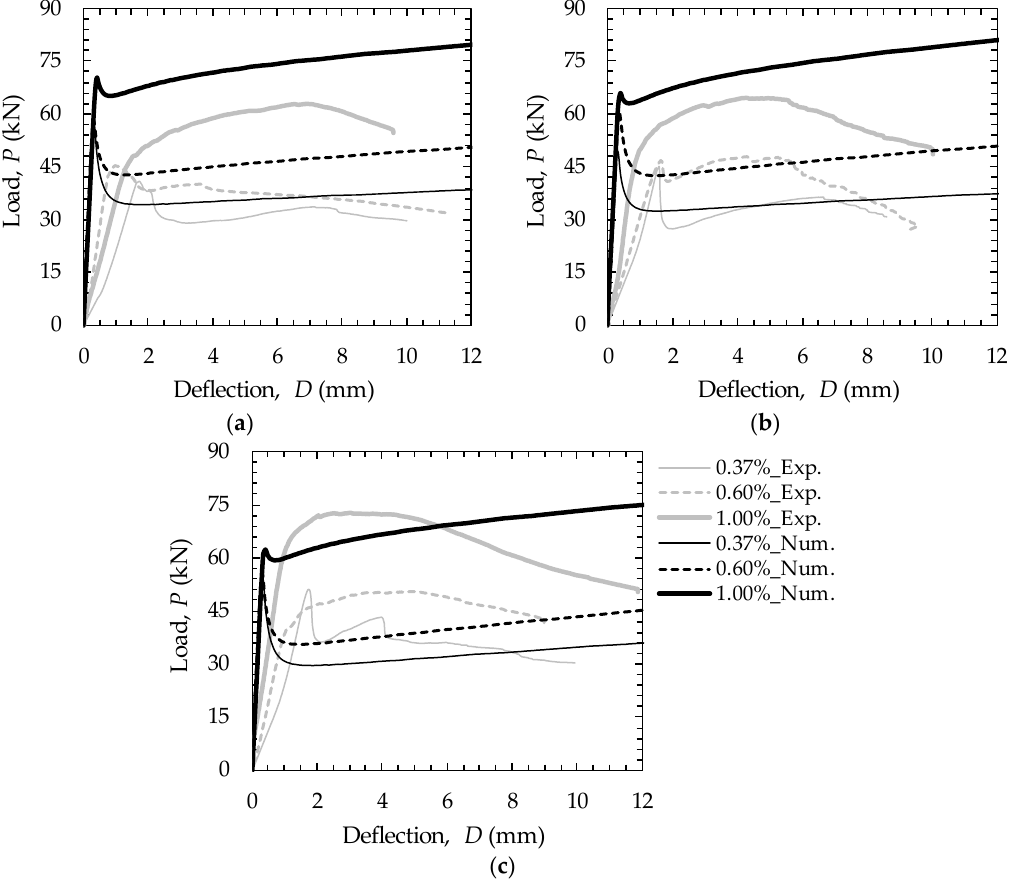
Figure 13. Comparative load versus deflection responses: ( a ) 3D fiber, ( b ) 4D fiber, ( c ) 5D fiber.